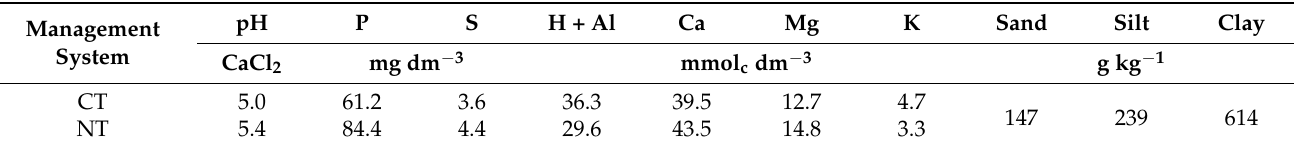
Table 1. Chemical and granulometric analysis of soil managed under conventional tillage (CT) and long-term no-tillage